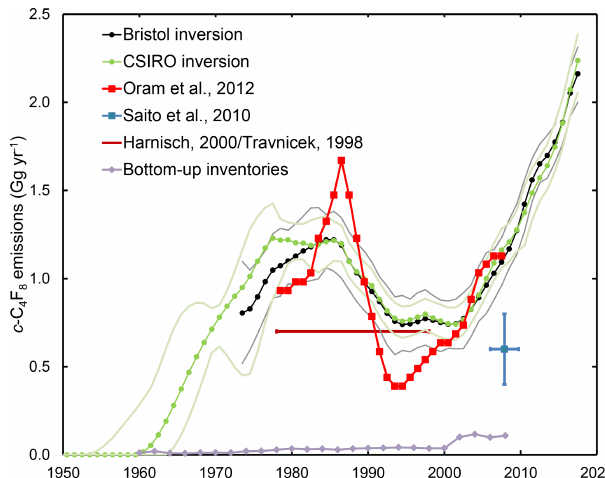
Figure 5. Global c -C 4 F 8 emissions reconstructed by the CSIRO in- version (green dots and line, light green 2 σ uncertainty bands) from 1950 and by the Bristol inversion (black dots and line, grey 1 σ un- certainty bands) from the early 1970s to present. In situ and archive data are used in both inversions, while firn air data are only used in the CSIRO inversion. Emission estimates by Oram et al. (2012) (red), Saito et al. (2010) (blue), Harnisch (2000)/Travnicek (1998) (brown), and from available bottom-up inventory information (grey) are shown for